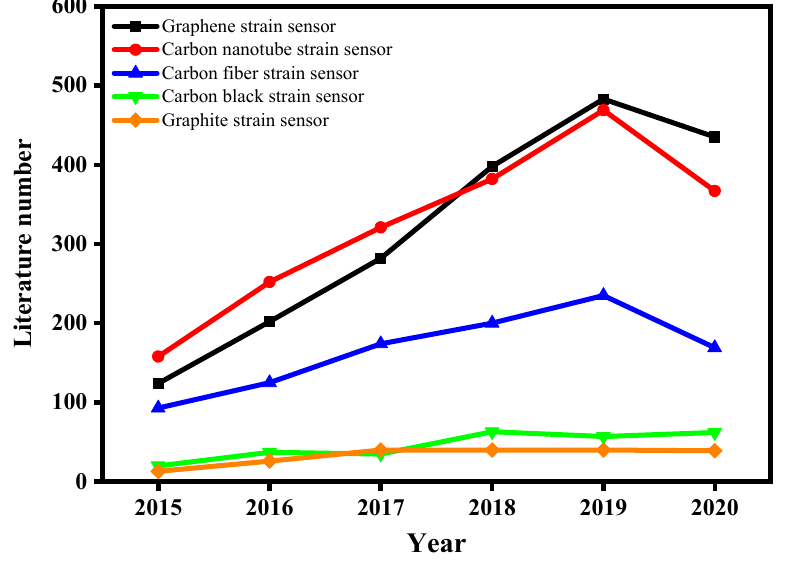
Figure 1. The development trend of carbon-based strain sensors in recent five years.